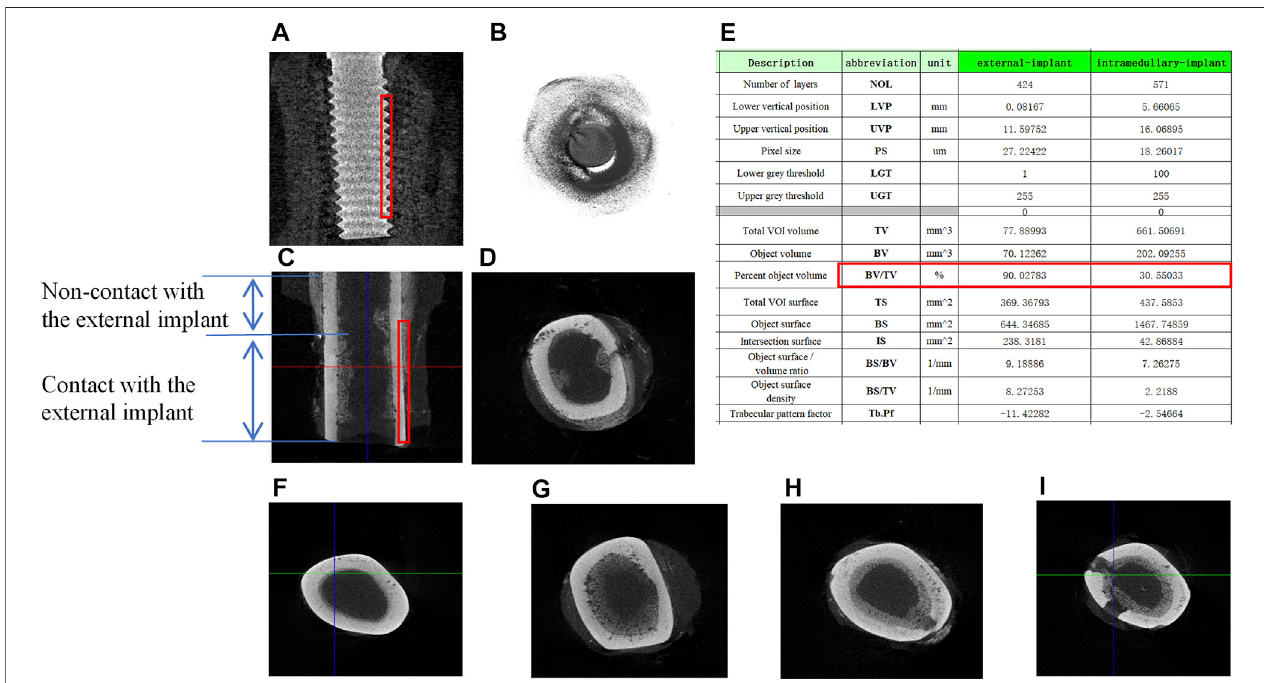
FIGURE5| Micro-CTscanandthedescriptionofbonetissueafterimplantation. (A) Longitudinalscanofsamplesaroundinternalcolumnarimplants,theredboxes indicate the total VOI volume; (B) transverse scan of samples around internal columnar implants; (C) longitudinal scan of samples around external cap implants; (D) transverse scan of samples around external cap implants; (E) the description of Micro-CT scan results; (F) transverse scan of the normal rabbit tibia; (G – I) new bone regeneration in the marrow cavity surrounded by the external